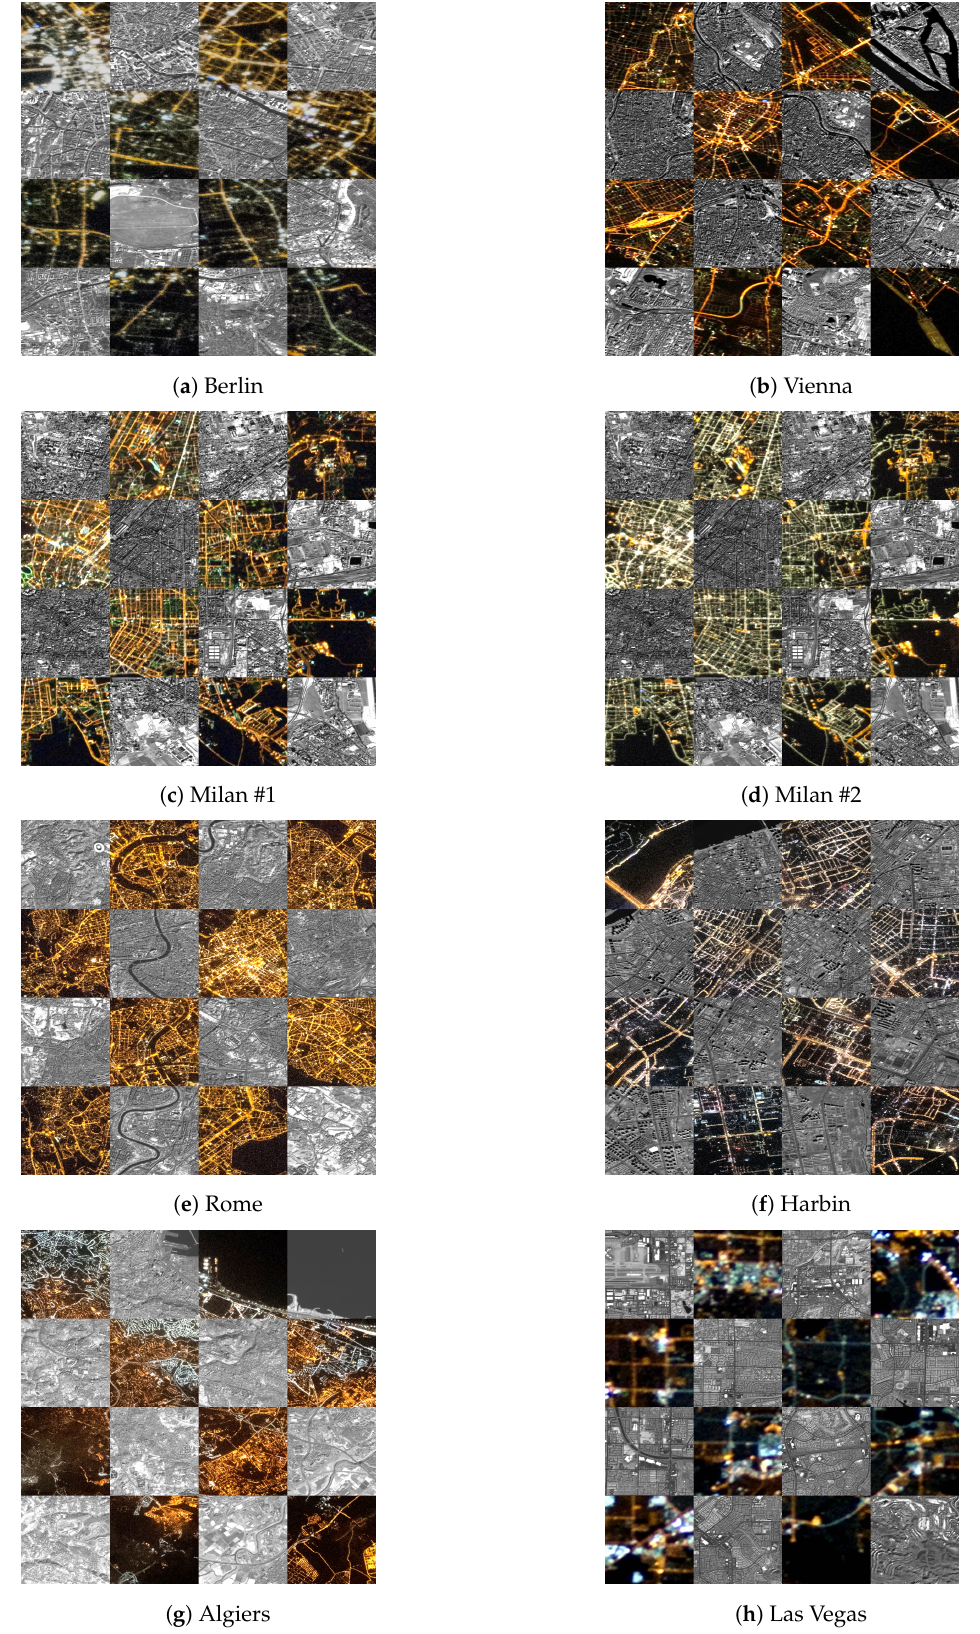
Figure 11. Subsection of georeferenced NTL scene (color image) overlaid onto reference Sentinel-2 image